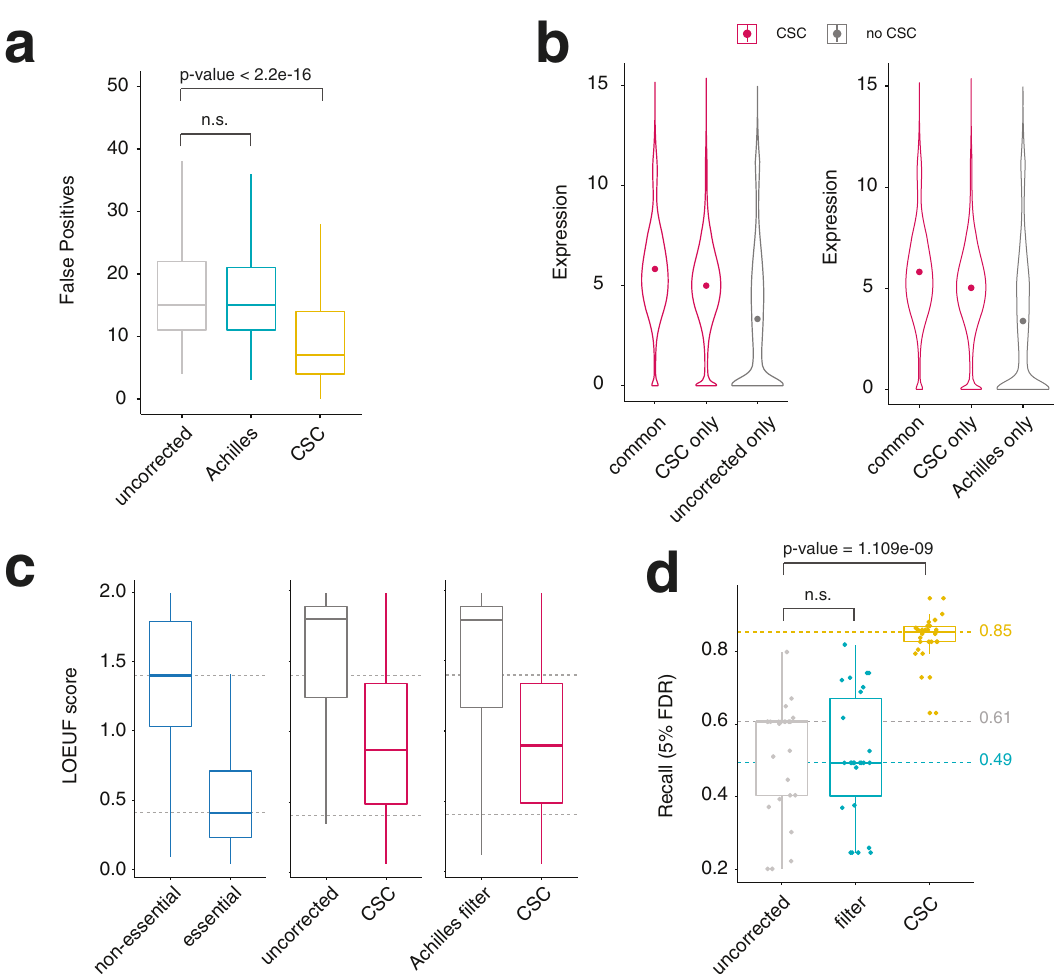
Fig. 4 CSC improves the identi fi cation of true gene dependencies. a Boxplot showing number of false positive hits for the 19Q4 Project Achilles dataset ( n = 689) before correction (grey), with the Achilles fi lter (blue), or with the CSC correction (yellow). For comparison purposes, Bayes Factor thresholds were varied to return the same number of hits across all three pipelines. p -values were calculated using a two-sided Wilcoxon test. b Violin plots showing the expression levels (log2(TPM + 1)) of genes in the cell lines in which they were identi fi ed as dependencies. Left graph shows genes identi fi ed both before and after correction (common), only after correction (CSC only) or only before correction (uncorrected only). Right graph shows genes identi fi ed as dependencies both in pipelines that implement CSC and Achilles (common), or only in one of the pipelines (CSC only, Achilles only). Dot represents the mean value. c Boxplots showing the LOEUF scores for genes identi fi ed as dependencies by only one of the pipelines. Exclusive dependencies are de fi ned as genes that score in more than 15 cell lines in one pipeline and none in the other (uncorrected versus CSC: n = 832; Achilles versus CSC plot n = 835). LOEUF scores for constitutive essential and non-essential genes are shown on the left as a reference ( n = 1169), and their median values are highlighted across all plots with a dashed line. d Recall values as in Fig. 2a but calculated using known constitutive essential and non-essential genes targeted by at least one unspeci fi c gRNA (H0 > 1). Filter corresponds to a pipeline where gRNAs with more than one perfect target site are removed before the analysis. Boxplots show minimum, maximum, median, fi rst, and third